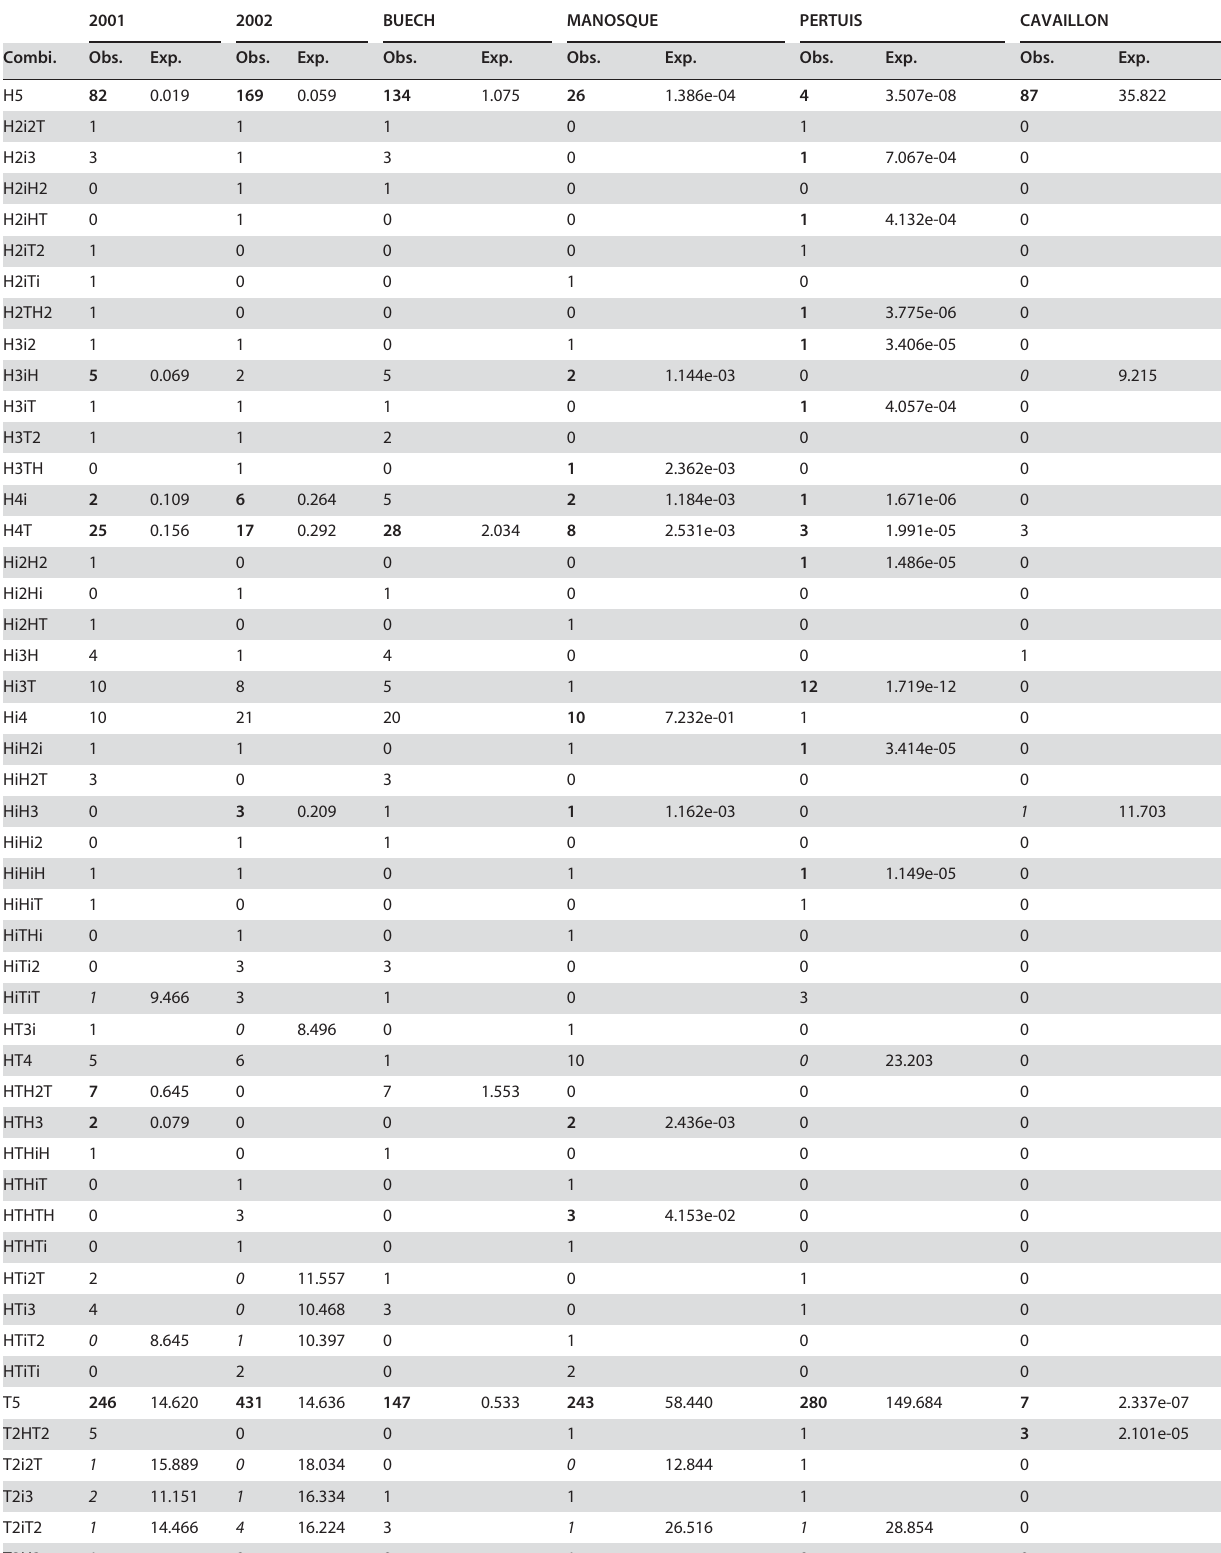
Table 1. OBSERVED AND EXPECTED EFFECTIVE SIZE OF EACH GENOMIC COMBINATIONS PRESENT IN THE HYBRID ZONE. .. ... .... ... ... .... ... ... .... ... ... .... ... ... .... ... ... .... ... ... .... ... ... .... ... ... .... ... ... .... ... ... .... ... ... .... ... ... .... ... ... .... ... ... . 2001 2002 BUECH MANOSQUE PERTUIS CAVAILLON Combi. Obs. Exp. Obs. Exp. Obs. Exp. Obs. Exp. Obs. Exp. Obs. Exp.